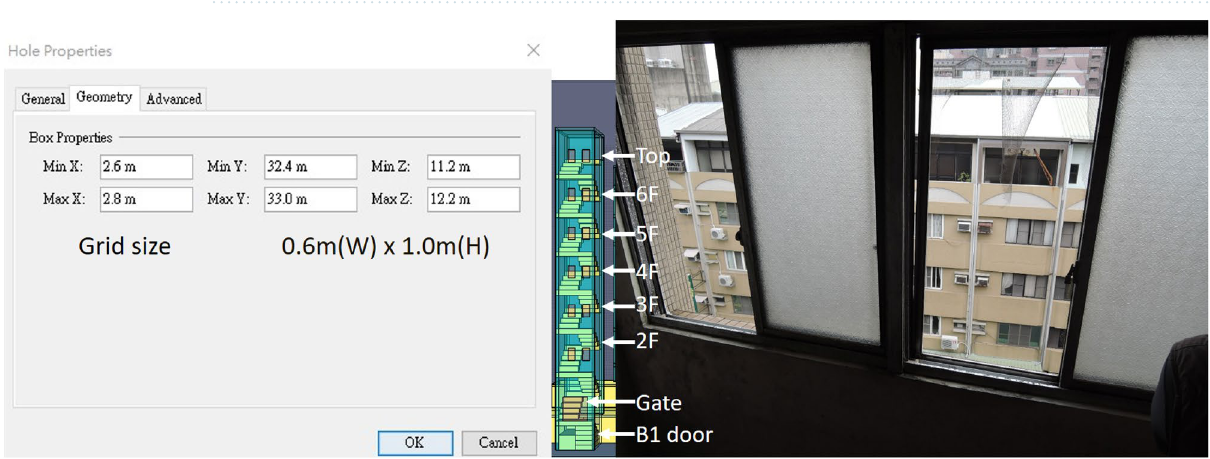
Figure 8. Configuration of the simulation model ( A ) Front view. ( B ) Top view.